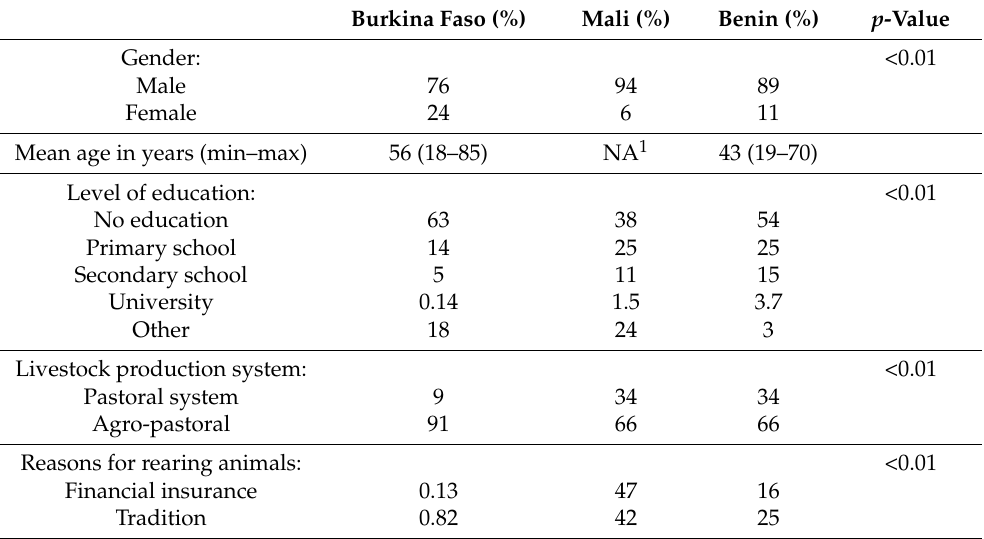
Table 1. General characteristics of participating farmers in Burkina Faso, Mali, and Benin, and their livestock production system and frequency of meat